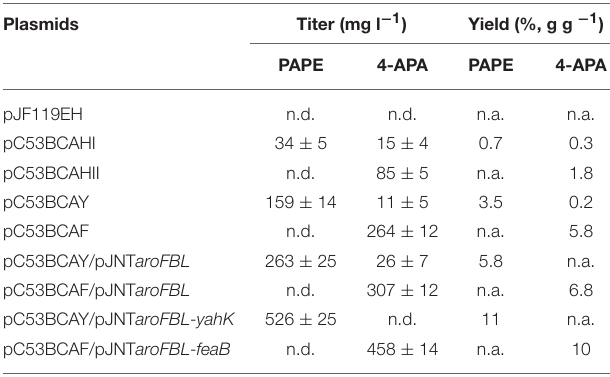
TABLE 1 | PAPE and 4-APA production by E. coli FUS4BCR strains harboring different combinations of plasmids.